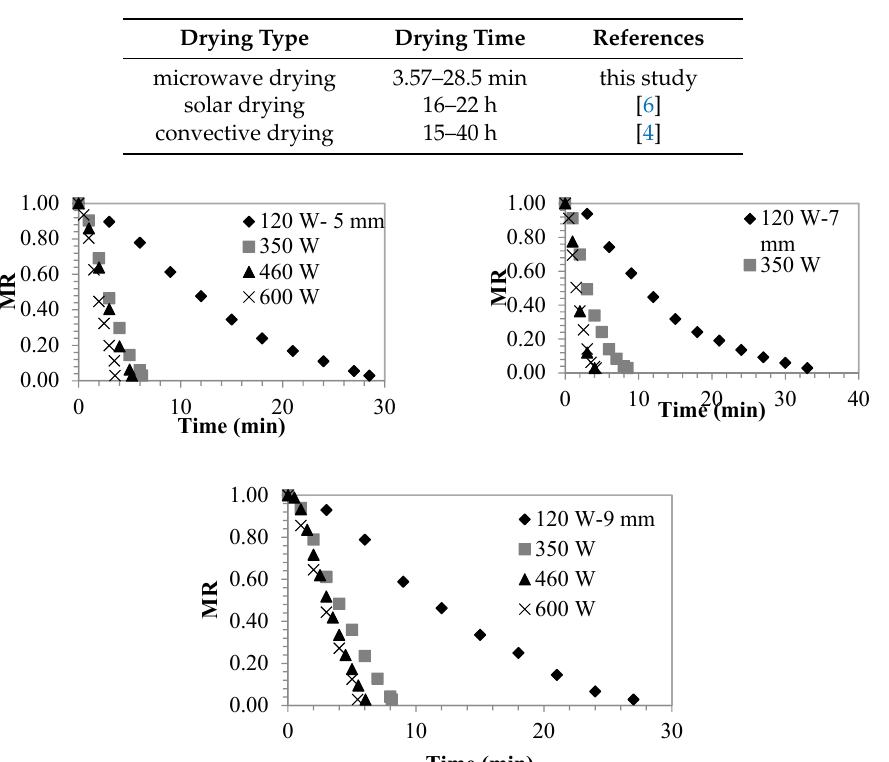
Table 1. Comparison of microwave drying with other drying methods.